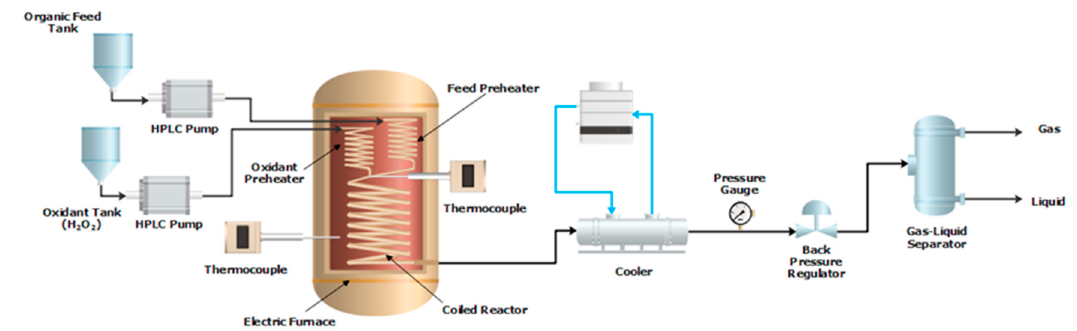
Figure 1. Schematic diagram of the continuous-flow reactor system.